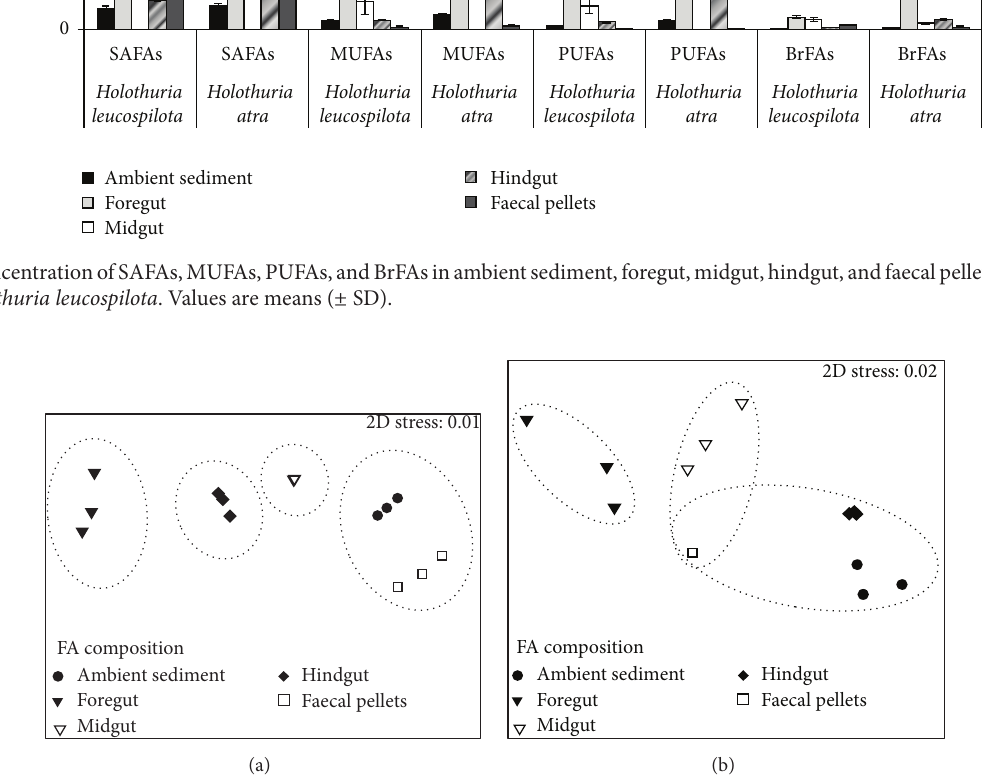
Figure 3: Nonmetric multidimensional scaling plot of the fatty acid composition ( 𝜇 gg −1 ) of ambient sediment, foregut, midgut, hindgut, and faecal pellets of Holothuria atra (a) and Holothuria leucospilota